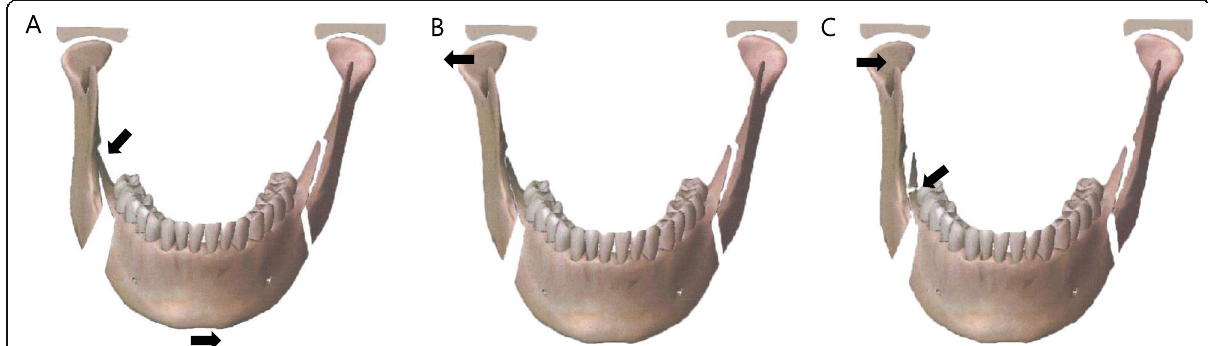
Fig. 2 Chin movement after BSSRO. A Bony interference occurs between the mesial and distal segment. B Torque occurs in the right condyle when the mesial segment is passively aligned. C Right condylar reposition by performing DSO